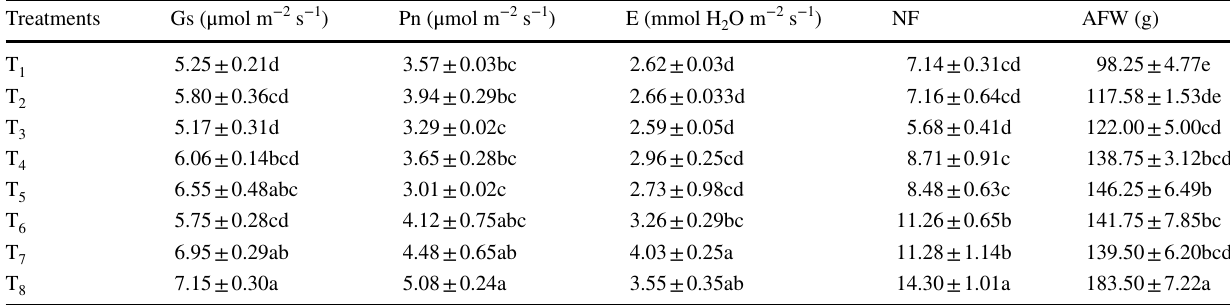
Table 4 Effect of different growing media on physiological and yield attributes of cucumber